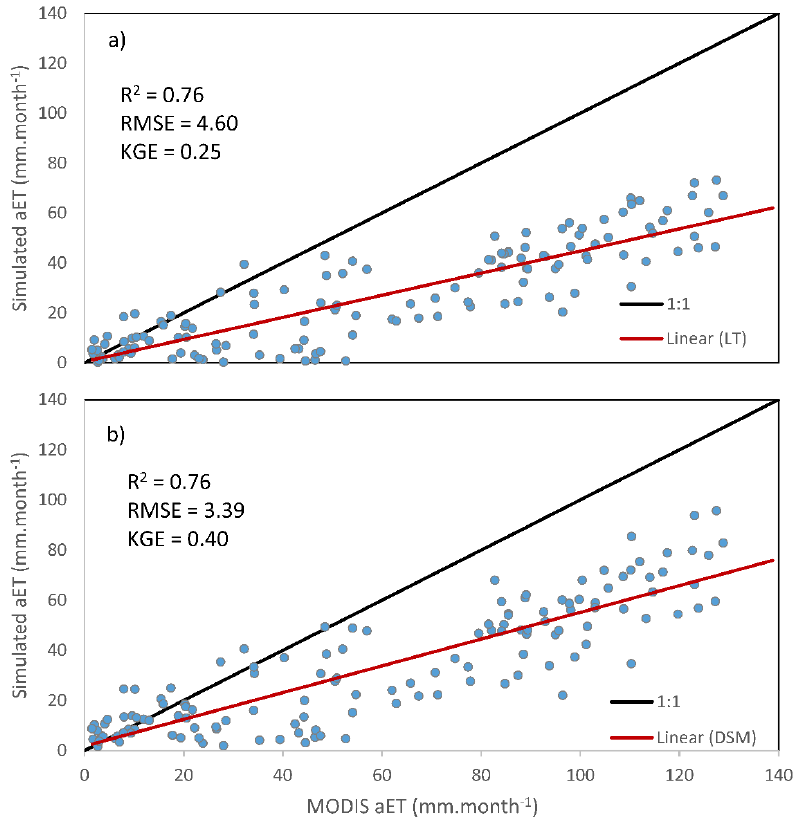
Figure 5. Monthly aET derived from MOD16 against simulated aET using ( a ) the LT soil dataset and ( b ) the DSM dataset for the entire basin.